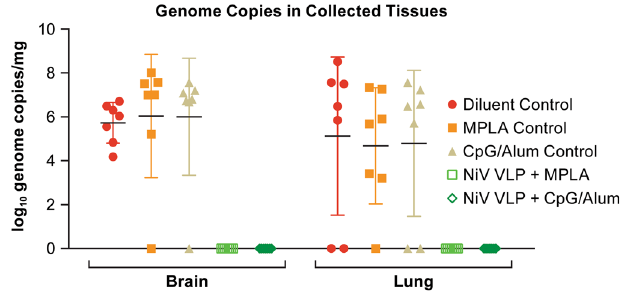
Fig. 6 PCR data from the single-dose vaccine trial. Data indicate the log 10 genome copies in the brain and lung collected at necropsy. Each marker represents an individual